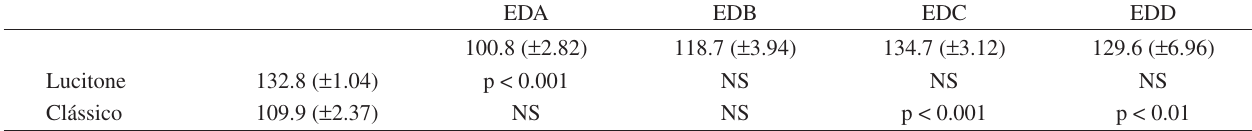
Table 3. Fracture resistance (MPa). Comparison of commercial materials and ground experimental materials (1-way ANOVA and Bonferroni’s test - p < 0.05).